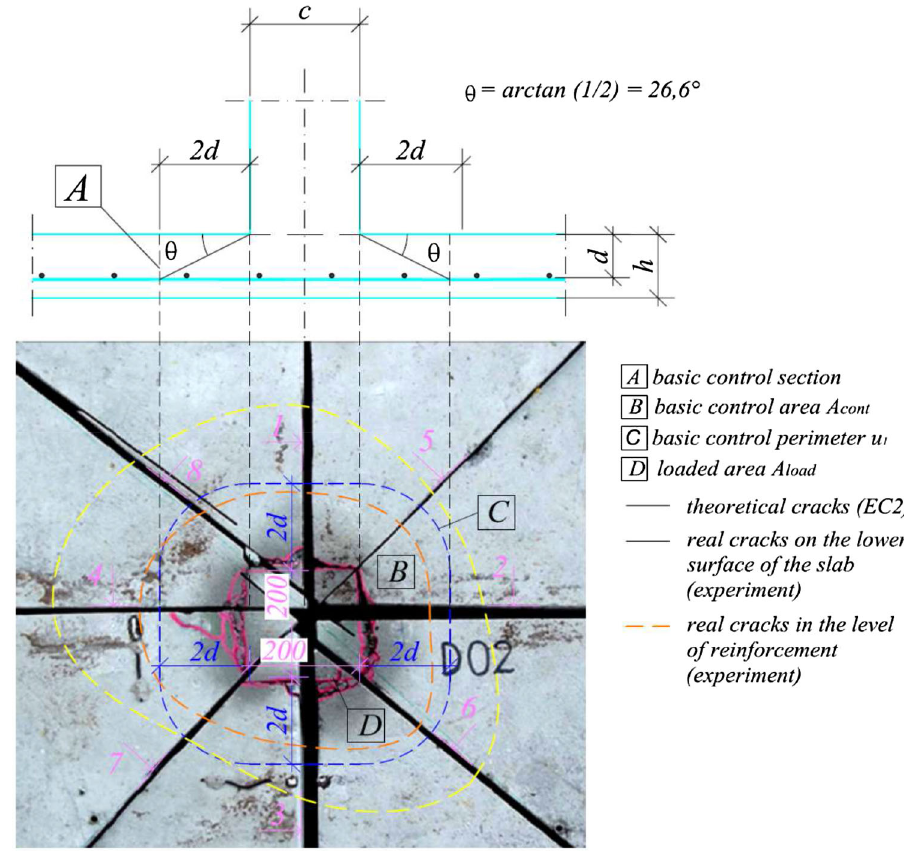
Fig. 7 Verification model for punching shear at the ultimate limit state (mm).